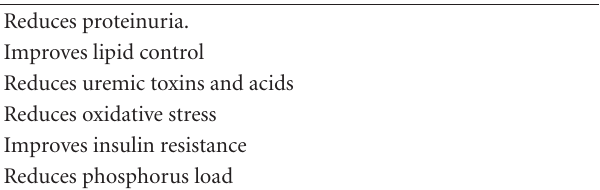
Table 1: Consequences of dietary protein restriction in advanced chronic kidney disease. Reduces